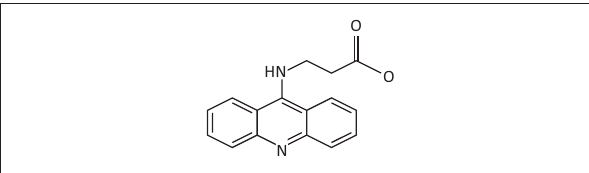
FIGURE 3: S-303 reaction product: